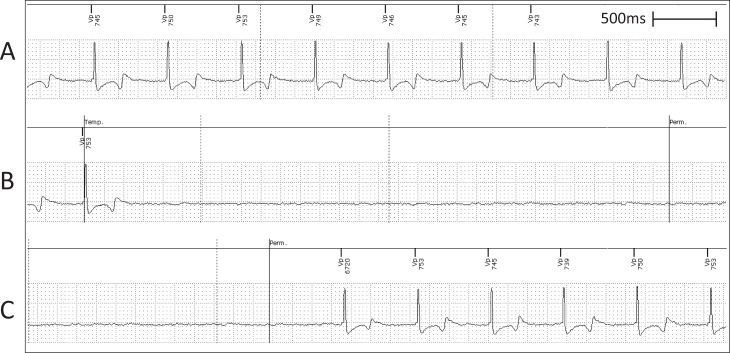
Lack of escape rhythm in the post-ablation follow up period.(A) Representative intracardiac ventricular lead recording depicting ventricular paced rhythm. (B) Representative lead recording showing lack of sinus rhythm when sensing feature activated by the pacemaker. Sensing period between the Temp. and Perm. lines. (C) Representative lead recording depicting return of ventricular pacing rhythm when sensing feature deactivated at Perm. line.